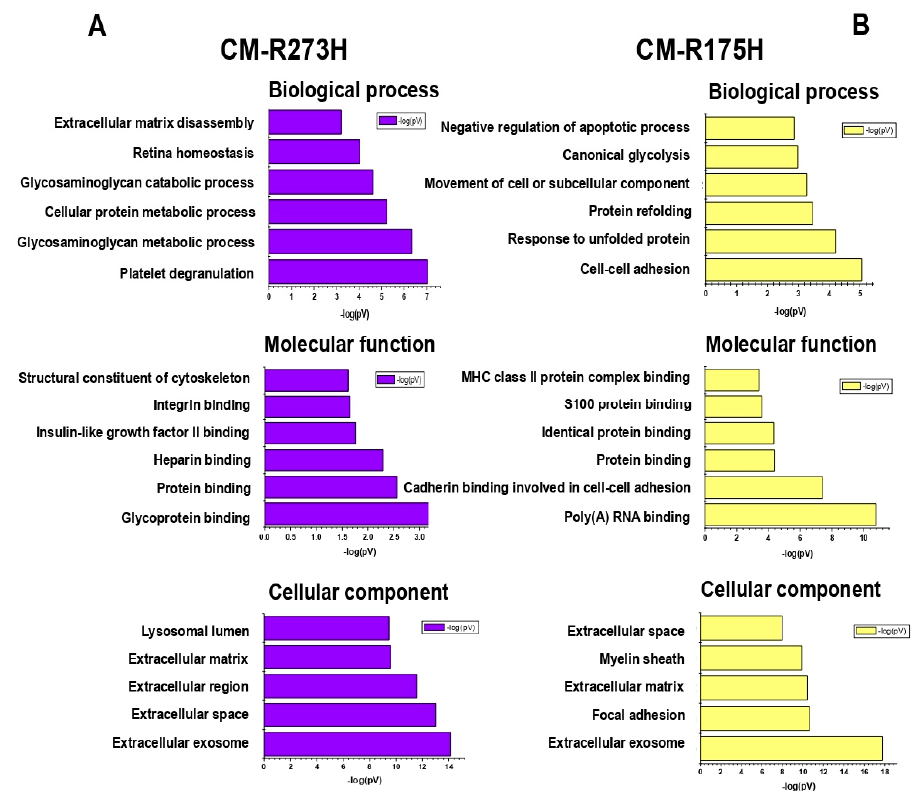
Figure 4. Bioinformatic analyses of enriched secreted proteins. Biological processes, molecular functions and cellular component of secreted proteins detected in ( A ) CM of R273H and in ( B ) CM of R175H transfected AsPC-1 cells.